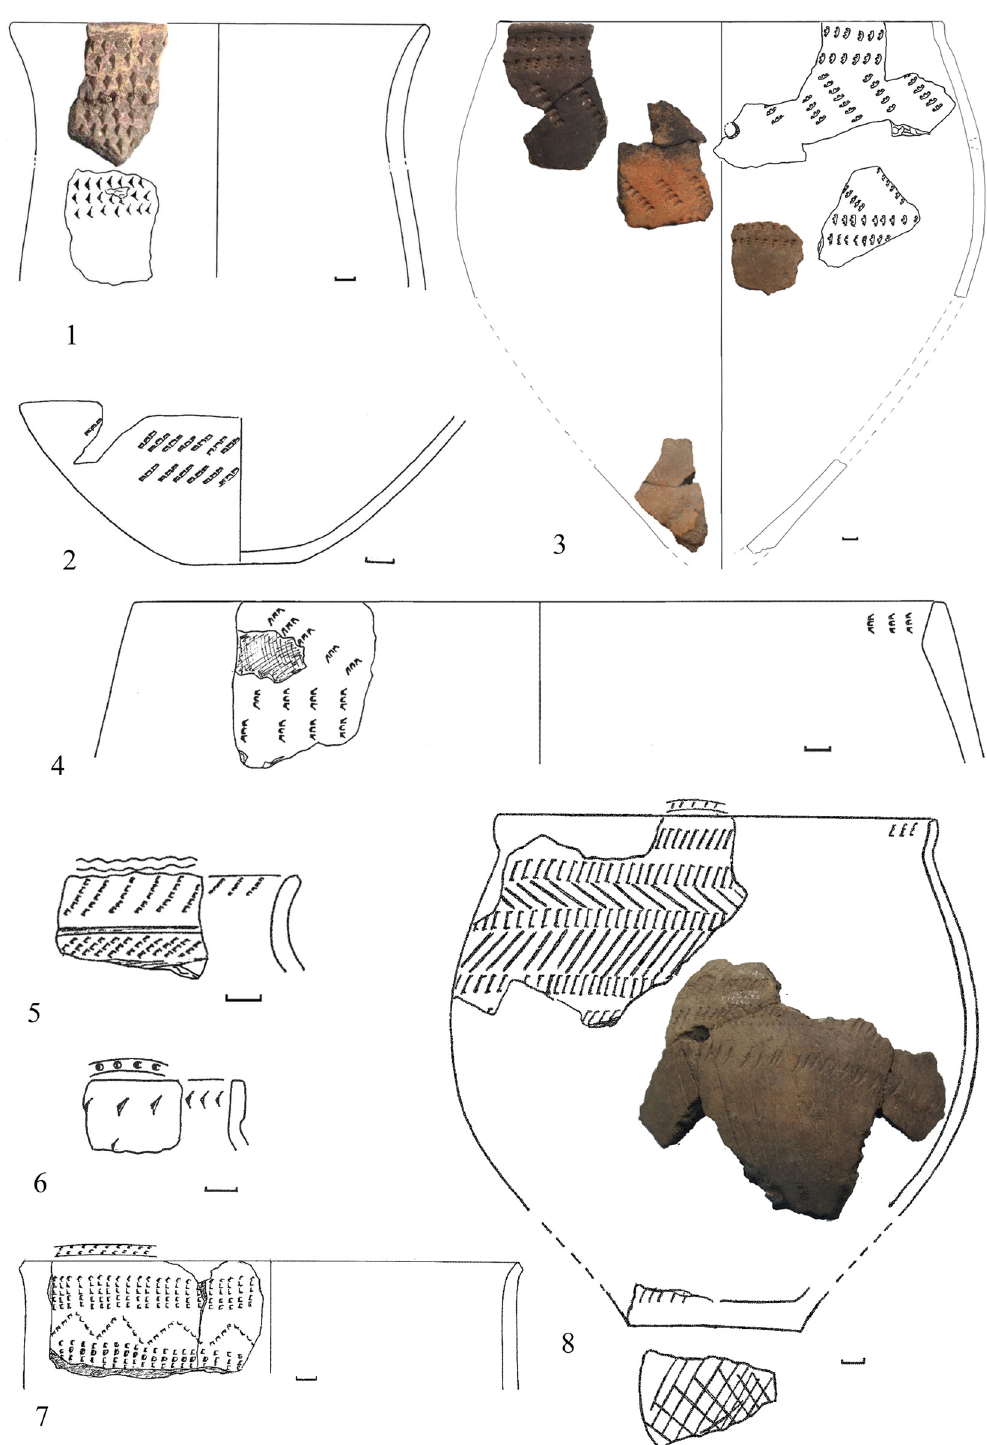
Figure 8: Vessels of Late Sursky culture under a pronounced Azov - Dnieper in fl uence. 1, 4, 7 – Kizlevy 5; 2, 5, 6, 8 – Strilcha Skelia; 3 – Kamyana Mohyla